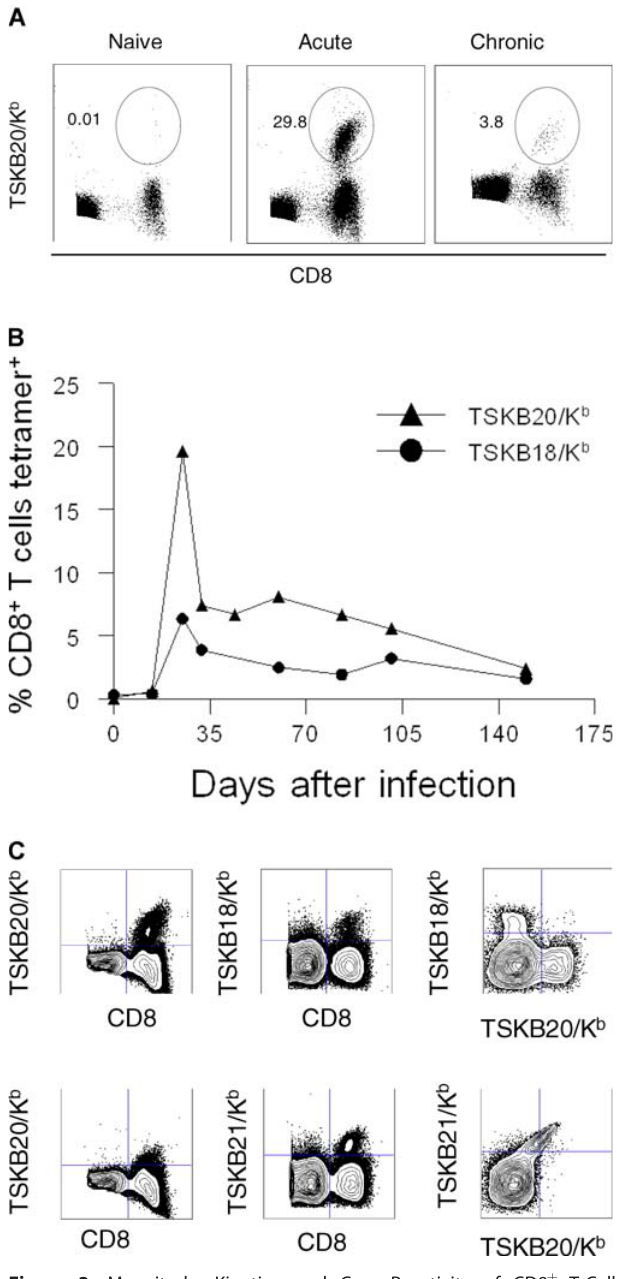
Figure 3. Magnitude, Kinetics, and Cross-Reactivity of CD8 þ T-Cell Responses to Dominant ts Epitopes